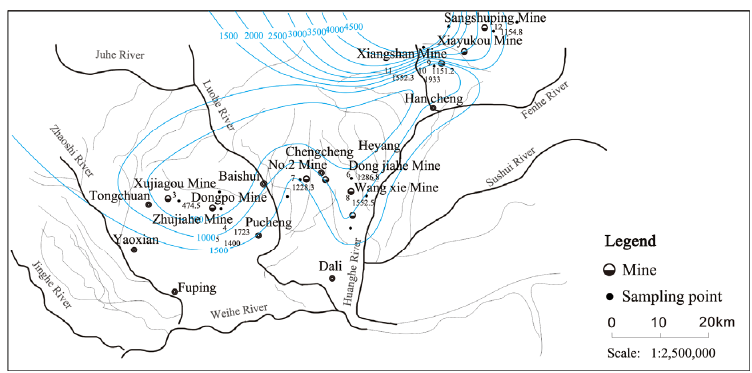
Figure 7. TDS contour line of Ordovician aquifer.